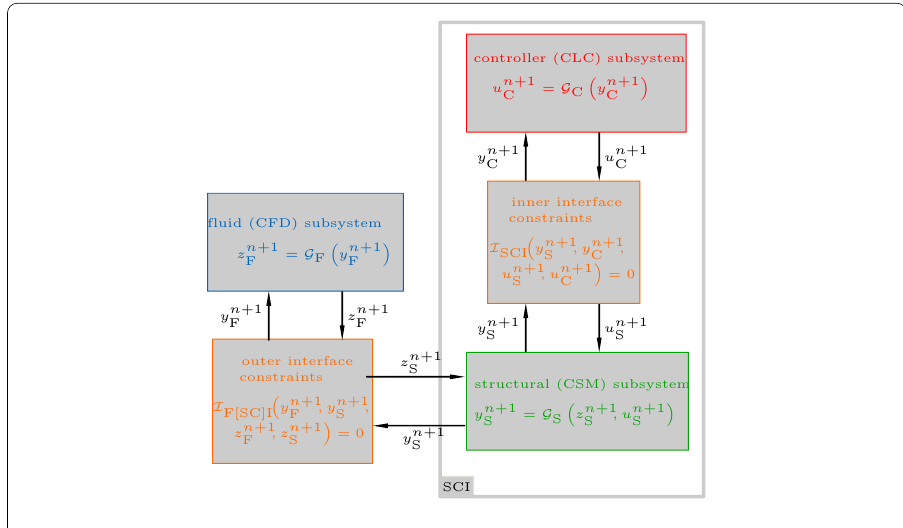
Fig. 4 Block diagram for F[SC]I